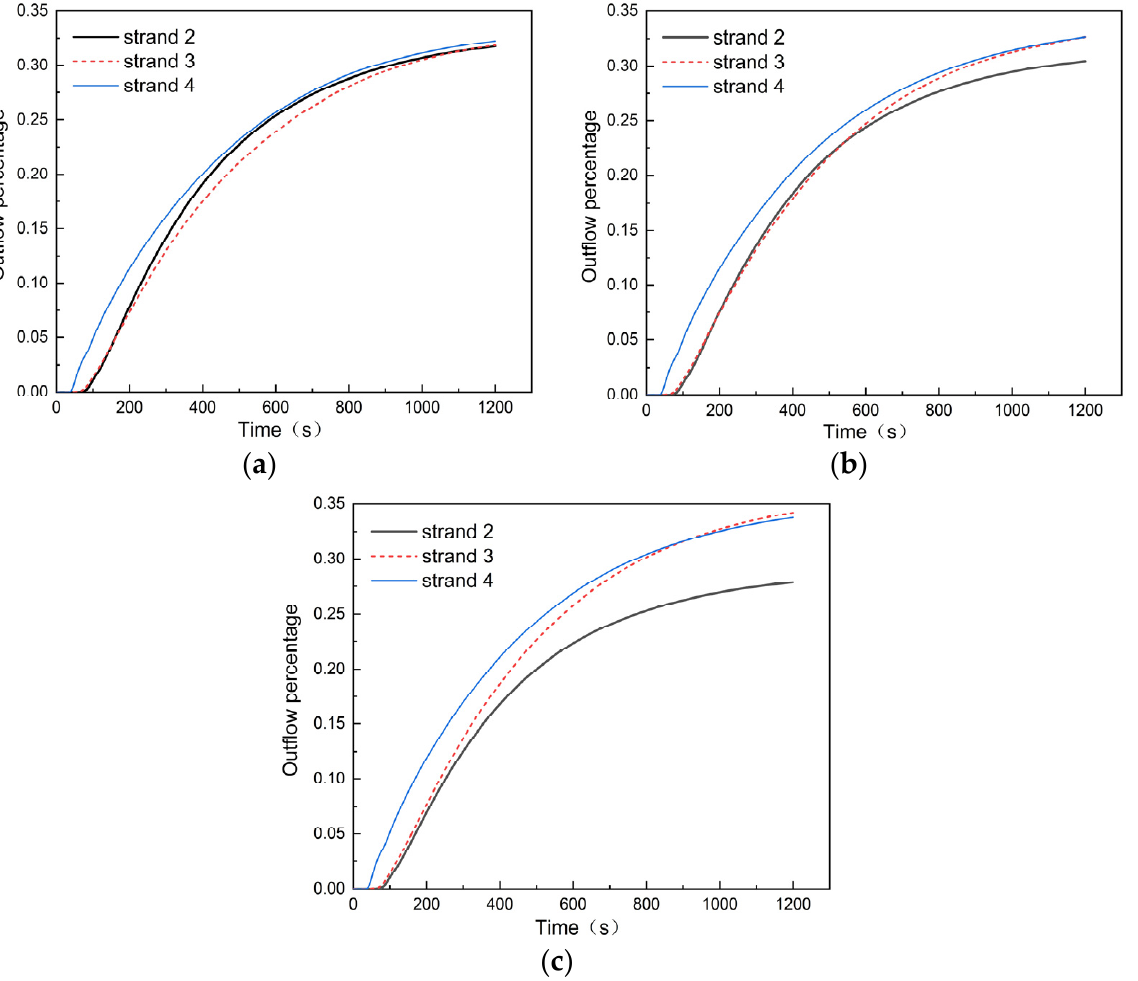
Figure 26. Outflow percentage curve of the u-shaped weir tundish with non-uniform increasing casting flow rate under strand 1 blockage condition: ( a ) 1.25 q, 1.375 q, 1.375 q, ( b ) 1.2 q, 1.4 q, 1.4 q, ( c ) 1.1 q, 1.45, 1.45 q.